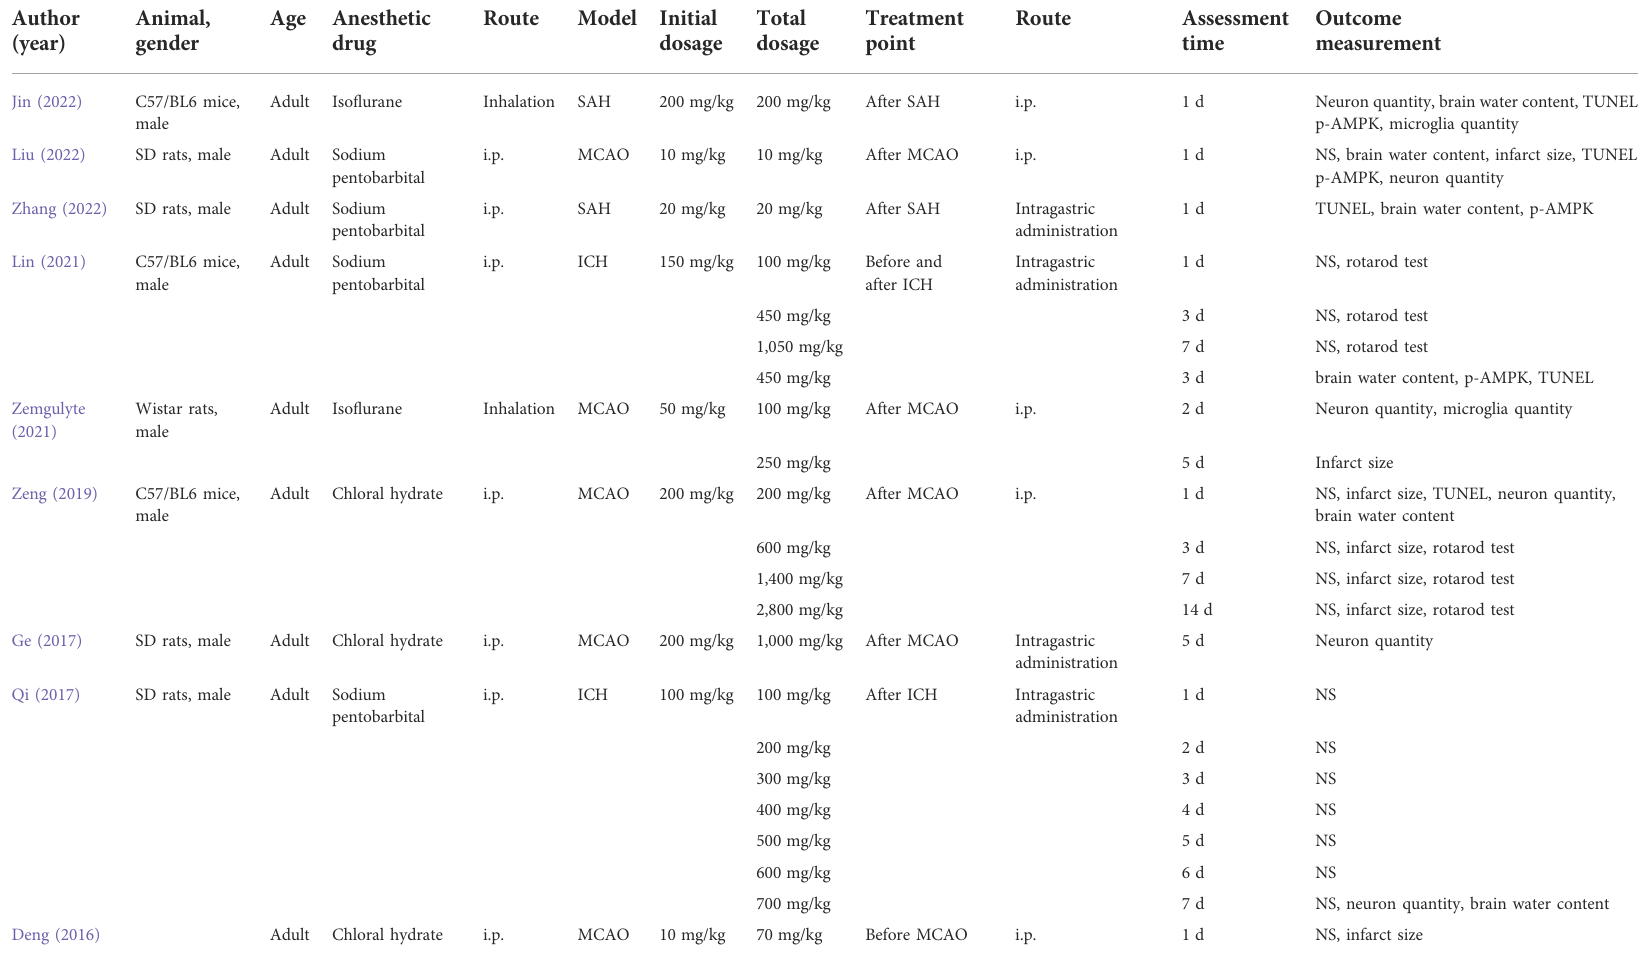
TABLE 1 Characteristics of the included